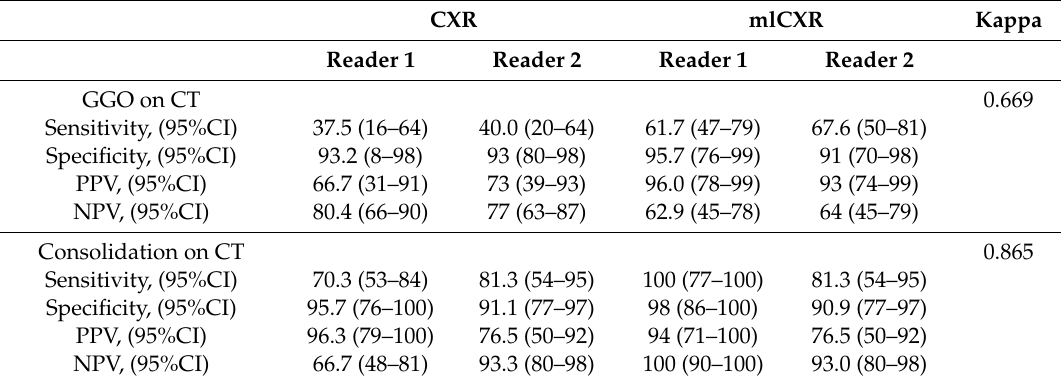
Figure 4. 51-year-old male COVID-19 patient with baseline imaging ( a , b ) and follow-up imaging 21 days after ( c , d ). At baseline, diffuse ground-glass opacification (GGO) and consolidation in both lobes were present. While consolidation (arrow) is well appreciated on ( a ) computed tomography (CT) as well as on ( b ) conventional radiography (CXR), GGOs (arrowheads) were only visible on CT (arrowheads). In the follow-up image, regredient consolidation (arrow) in the left lower lobe can be appreciated on both ( c ) CT as well as ( d ) CXR, while changes in the extent of GGO were only appreciated on CT. Table 4. Diagnostic accuracy for pattern